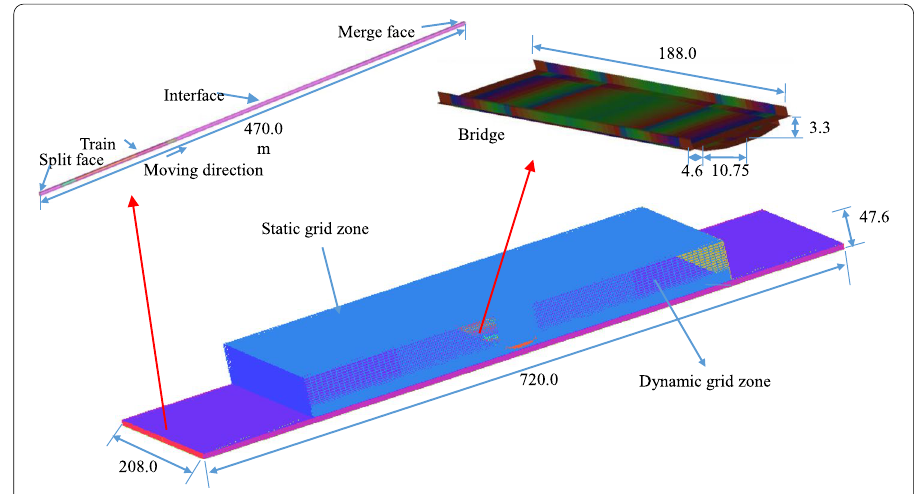
Fig. 4 Flow field model (unit: